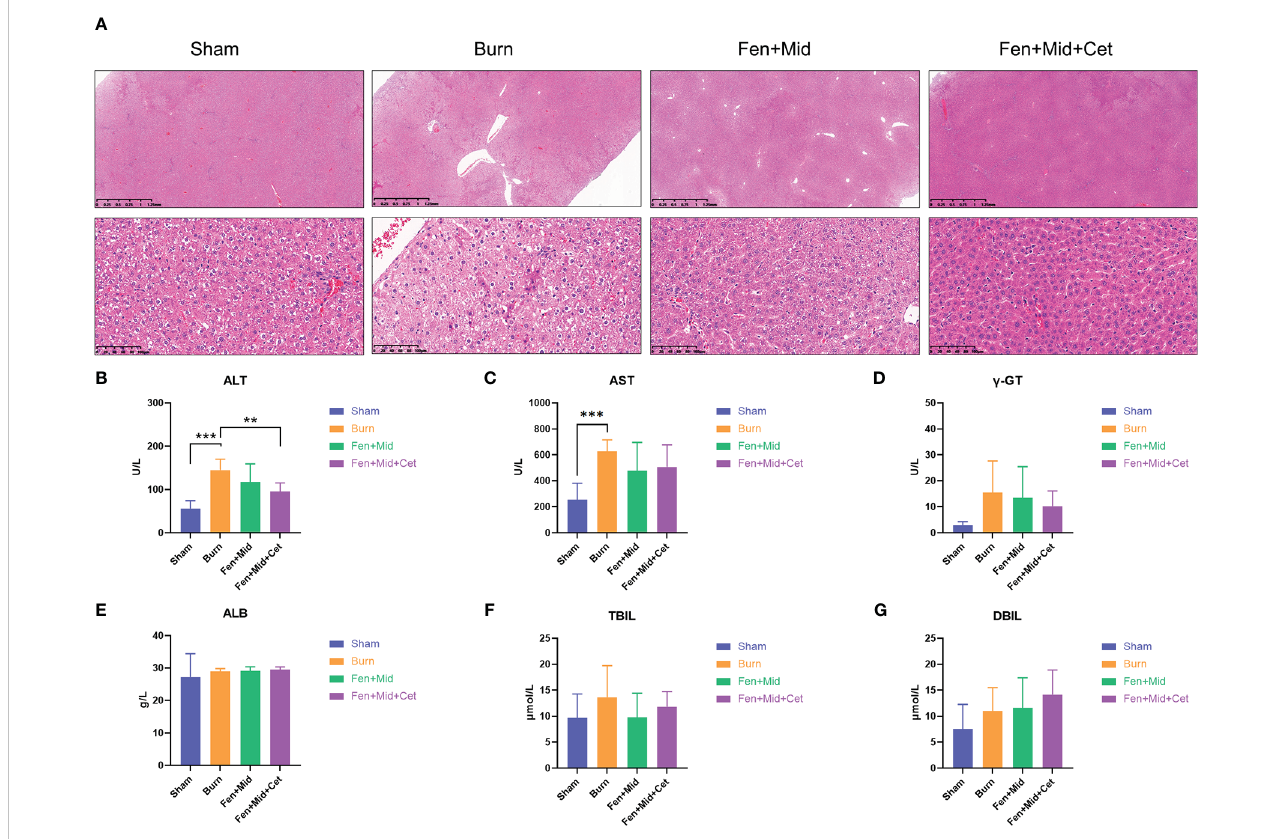
FIGURE 3 Effects of fentanyl and midazolam combined with cetirizine on liver injury in rats after severe burns. (A) The liver tissues of rats in large area scald group (Burn), sham scald group (Sham), fentanyl + midazolam group (Fen+Mid), or fentanyl + midazolam + cetirizine group (Fen+Mid+Cet) were stained with HE. The scale bar indicates 1.25mm or 100 µm, respectively. The plasma of rats in each group was measured with alanine aminotransferase (ALT, (B) ), aspartate aminotransferase (AST, (C) ), g -Glutamine transferase ( g -GT, (D) ), Albumin (ALB, (E) ), Total bilirubin (TBIL, (F) ), and Direct Bilirubin (DBIL, (G) ) levels. n = 6, ** p < 0.01, *** p <